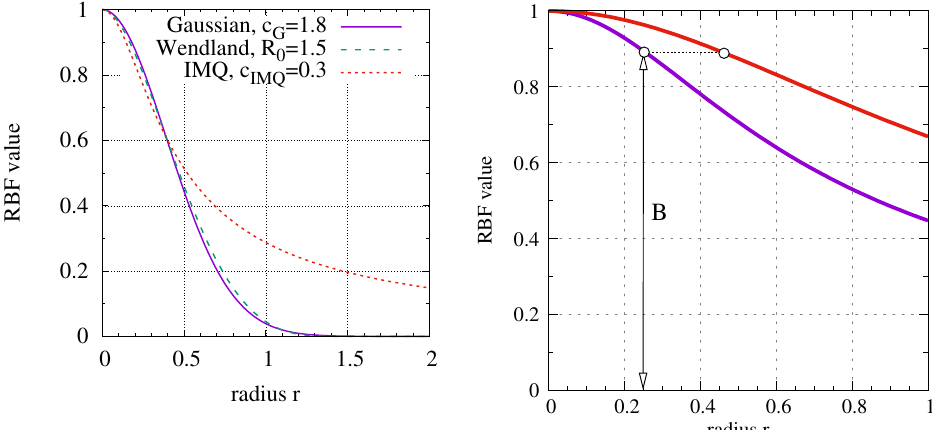
Figure A1. ( left ) Comparison of the three RBFs chosen so that similar curves result, ( right ) similarity estimation to obtain shape parameter in dependence of the point distance ∆ d